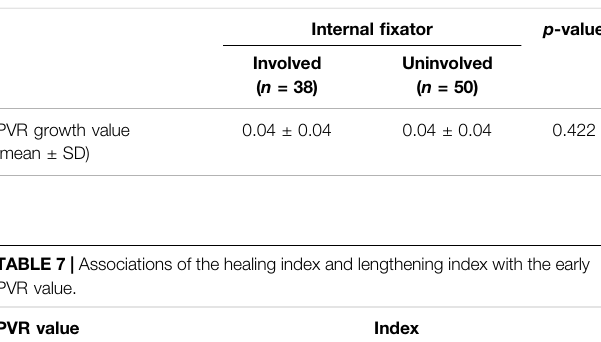
TABLE 6 | Subgroup analysisfor thePVR growth based onthe involvement ofthe internal fi xator during the consolidation period.